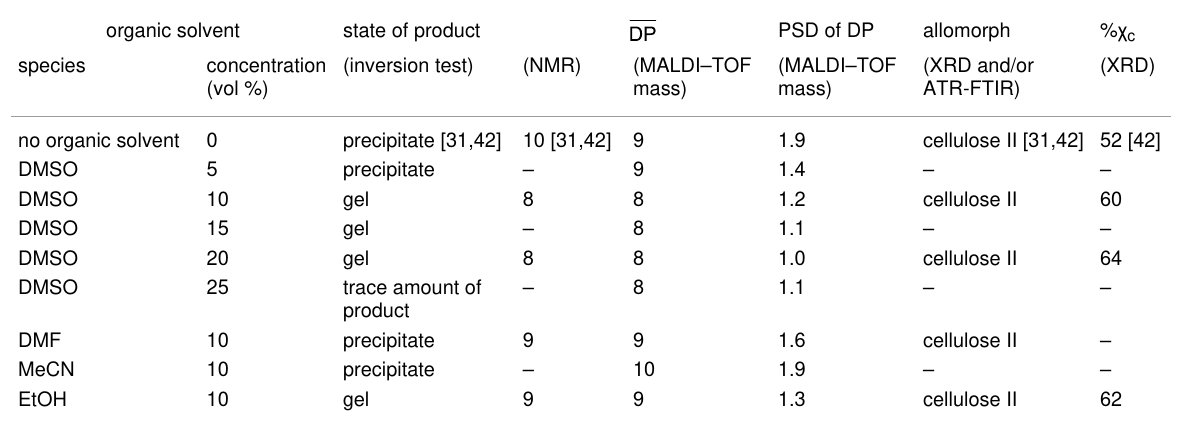
Table 1: Summary of CDP-catalyzed oligomerization reaction with organic